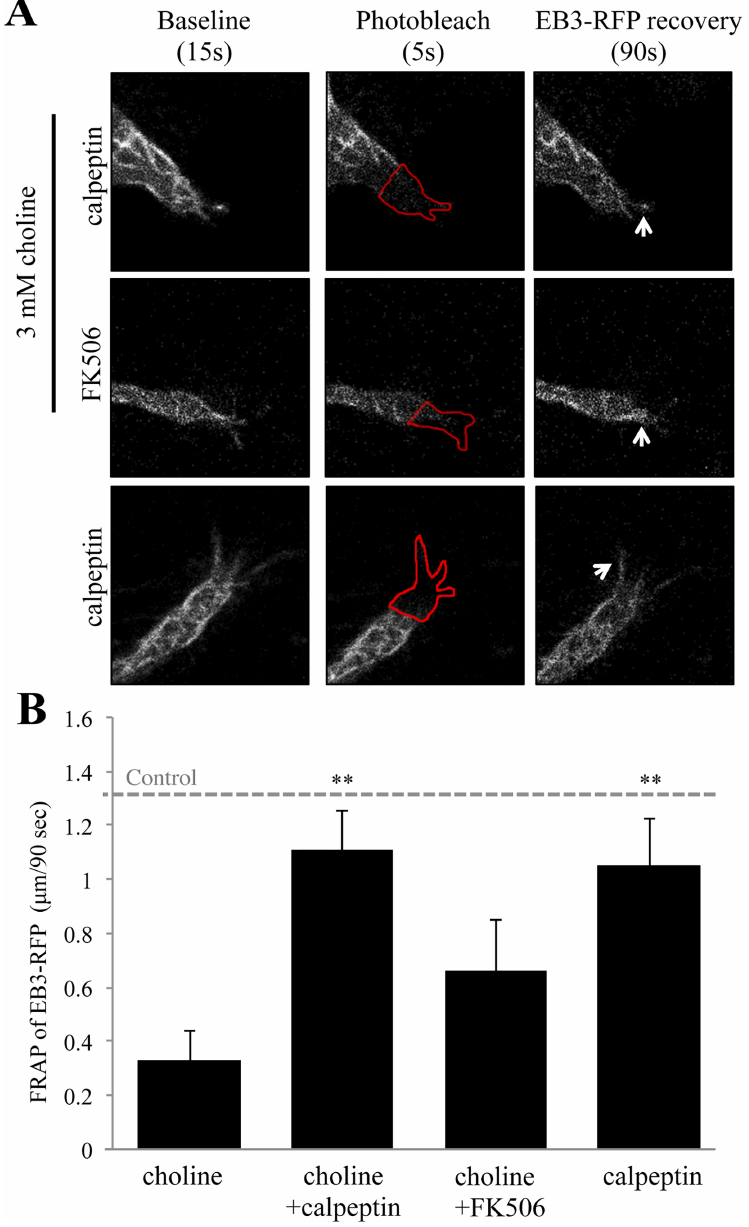
Fig 4. Inhibition of calpain but not calcineurin abolishes choline regulation of EB3 comet velocity. (A) Representative images of choline (3 mM) mediated EB3 comet motility in calpeptin (26 μM) and FK506 (40 μM) pre- treated cells during the experiment. Arrows point to the location of EB3 comets after photo-bleaching in the ROI indicated by a red outline. (B) Average distance traveled by EB3 comets following photo-bleaching in treated cells relative to Control: EB3 comet velocity in non-treated cells. ( (cid:3)(cid:3) = p < 0.005; n = 18 cells per group).